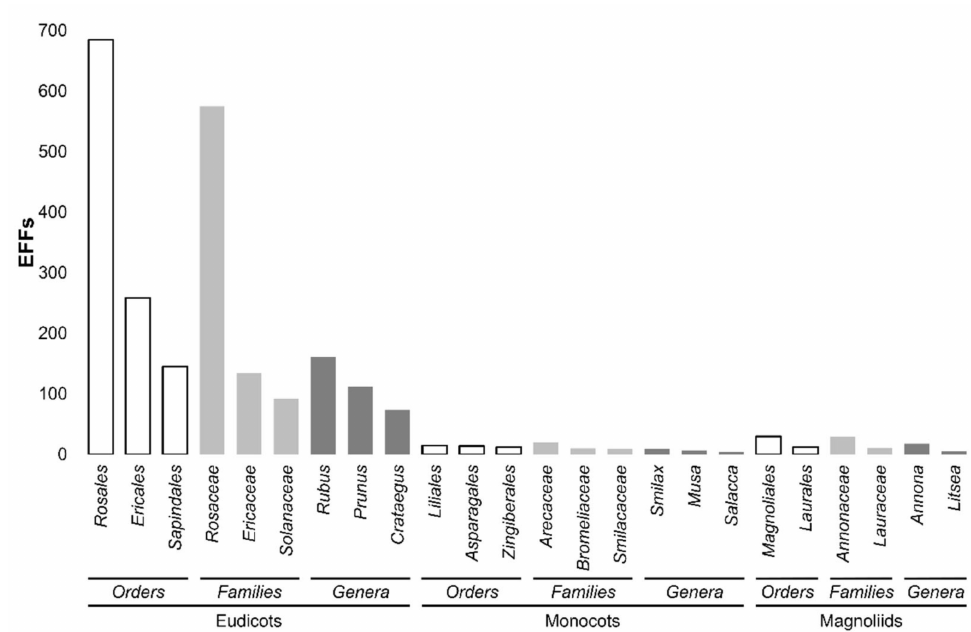
Figure 1. Taxonomy of all EFFs in the world. Classification of more than 2000 EFFs shows the most representative orders, families, and genera to which they belong. Note the increasing inclusivity of the higher taxonomic ranks such as families, orders, and finally clades (eudicots, monocots, and magnoliids). Complete information is found in Supplementary Table